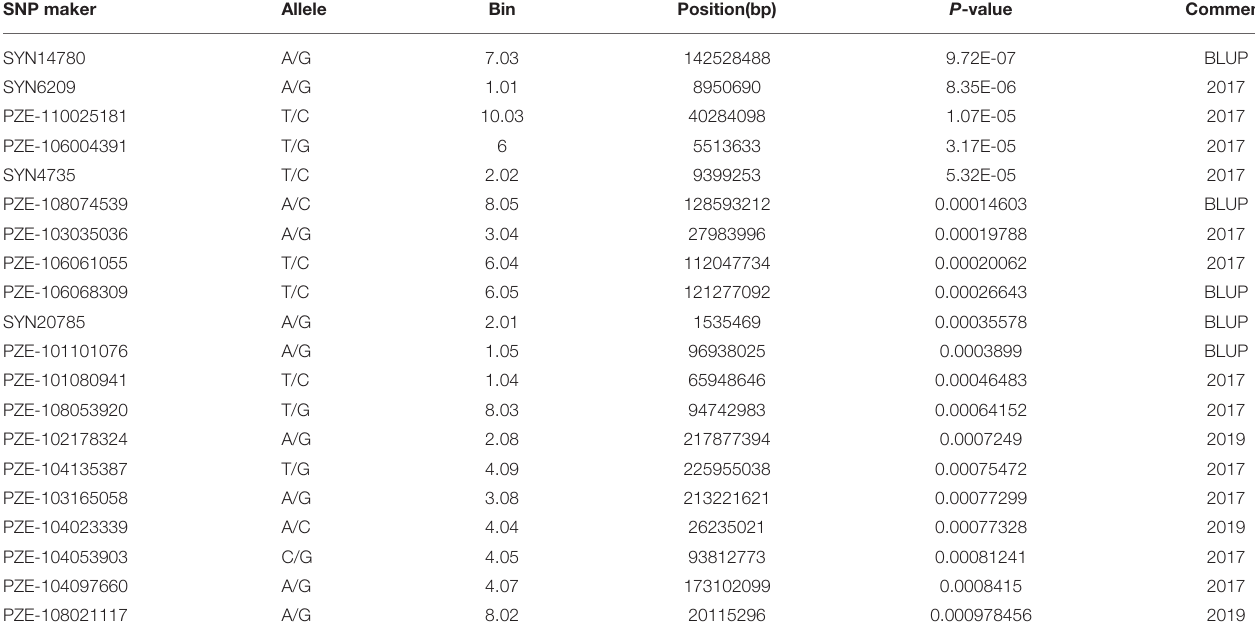
TABLE 2 | The SNPs closely related to stalk rot in maize. SNP maker Allele Bin Position(bp) P